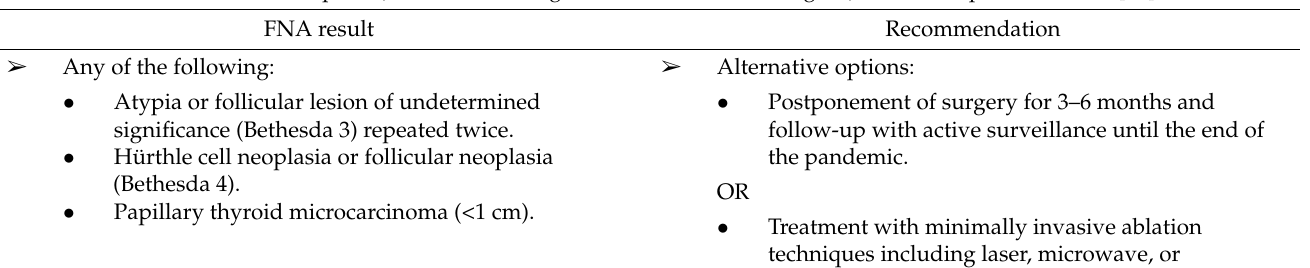
Table 3. COVID-19 pandemic guidelines for management of thyroid tumors with focus on DTC by diverse expert committees. Committee of 67 experts (45 endocrine surgeons and 22 endocrinologists) from multiple countries a [73]. FNA